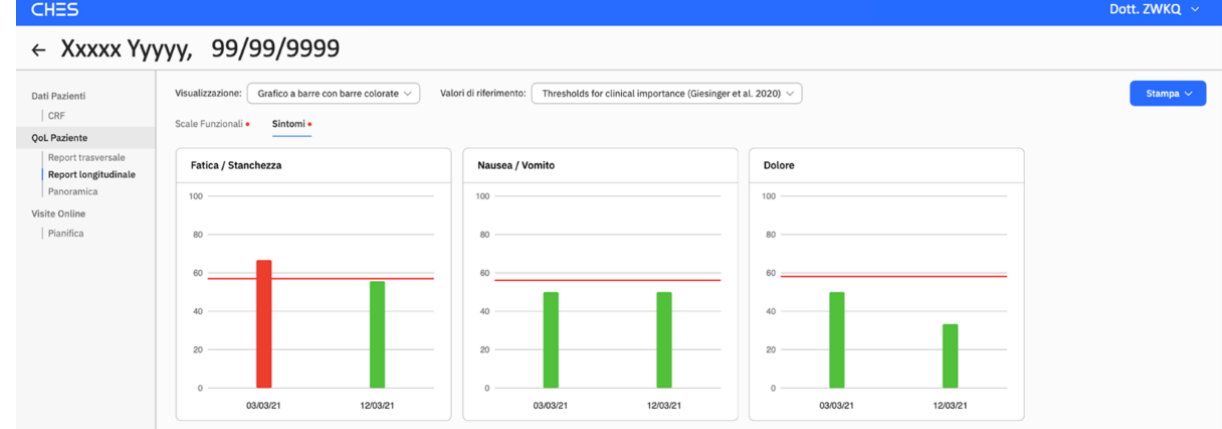
Figure 4. Example of graphical display of results of patient-reported symptoms available on the physician portal. The red vertical bar indicates a clinically important